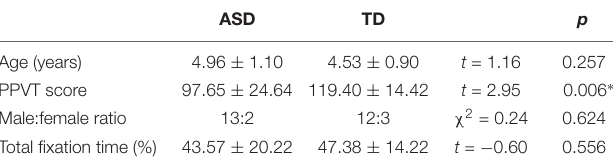
TABLE 1 | Demographic details of the final